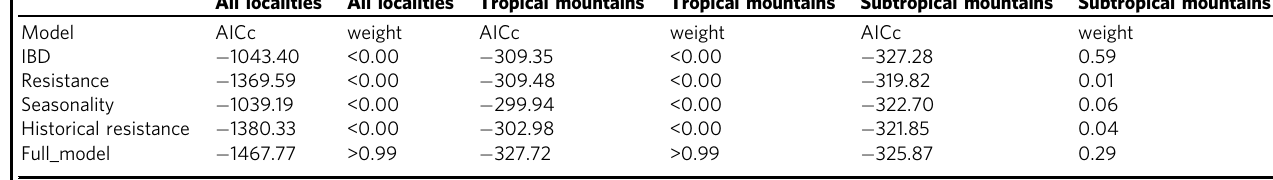
Supplementary Table 3; p value <0.001). In all tested cases,